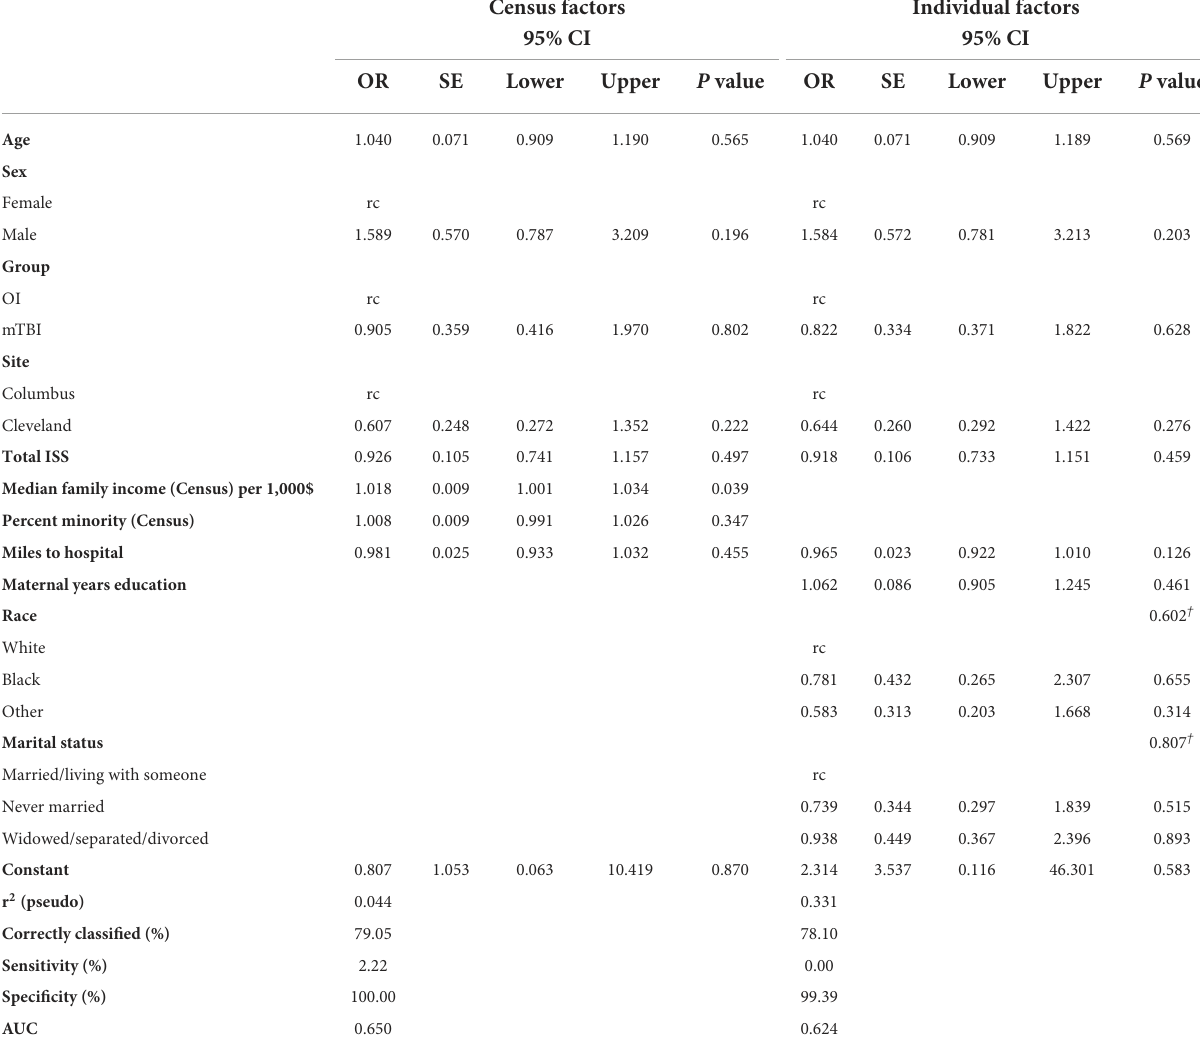
TABLE 5 Multivariable model–odds of returning for a follow-up visit after completing post-acute visit. Census factors Individual